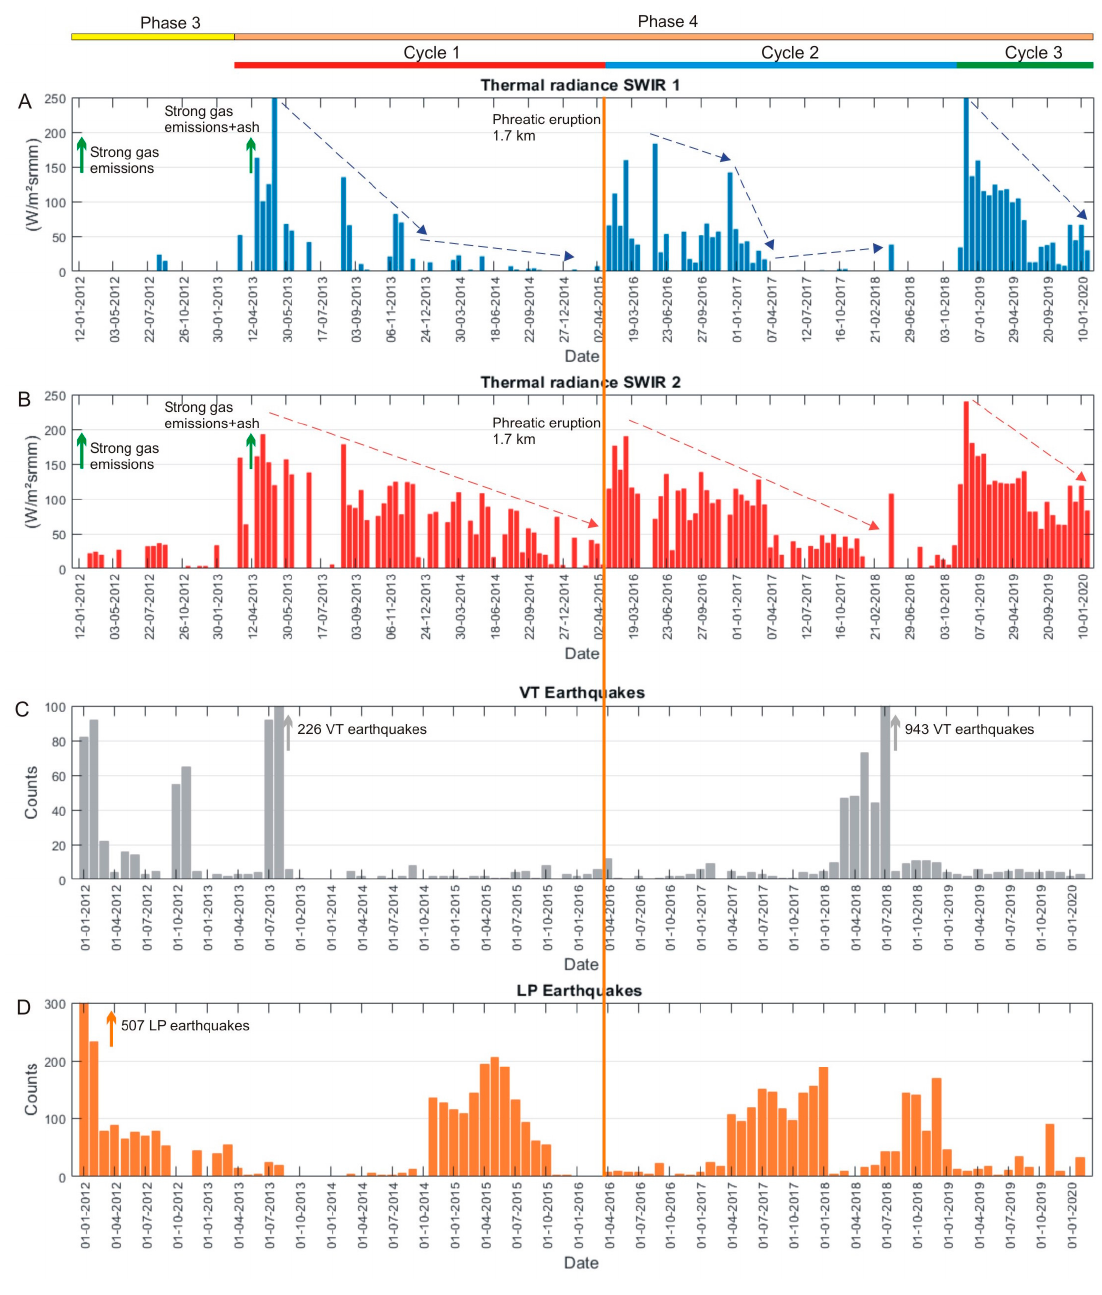
Figure 10. Lascar Volcano. ( A ) Thermal radiance of SWIR1 band vs. date for the period January 2012–February 2020. ( B ) Thermal radiance of SWIR2 band vs. date for the period January 2012–February 2020. ( C ) VT seismicity vs. date for the period January 2012–February 2020. ( D ) LP seismicity vs. date for the period January 2012–February 2020. The upper part shows phases 3 and 4, and the three cycles defined by the correlation between thermal radiance and volcanic activity in phase 4 . The orange line indicates the occurrence of the 30 October 2015, phreatic eruption and the upward green arrows indicate strong gas emissions.